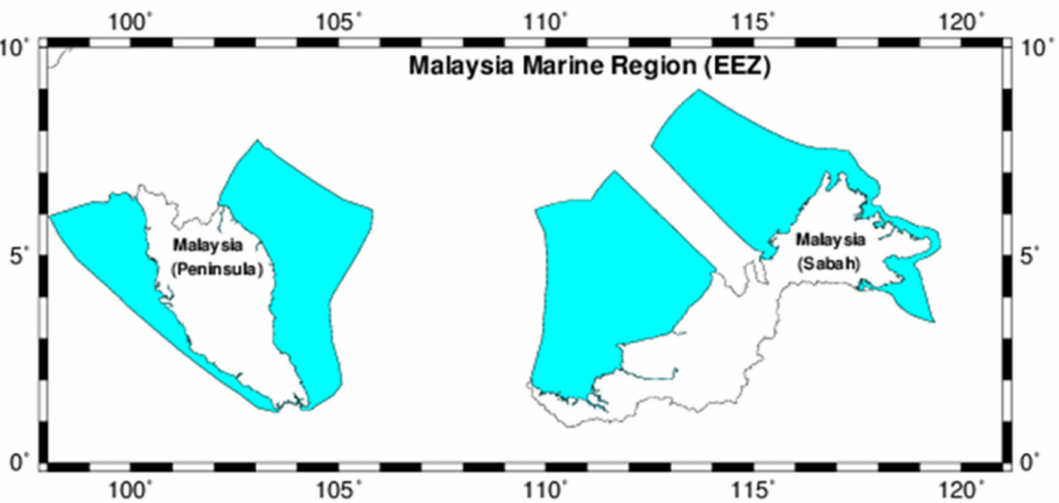
Figure 1. Areas highlighted in light blue are the overall Malaysian Marine Region—Exclusive Economic Zone (EEZ). This map shows 98 degrees to 121 degrees east in longitude and the equator to 10 degrees north in